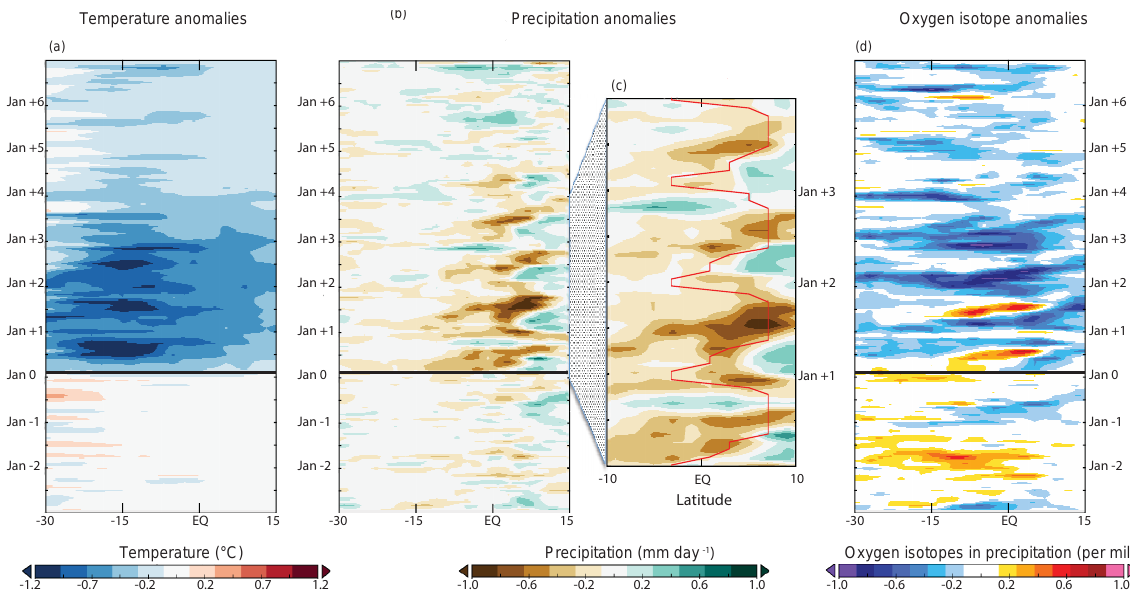
Figure 11. Last millennium Hovmöller diagram (10 years, time moving forward going upward, with year number labeled next to each month) for (a) temperature anomaly ( ◦ C) and (b) precipitation anomaly (mmday − 1 ) using procedure described in the text. Solid black lines mark closest January to start of each eruption used in composite. (c) Same as panel (b) , except zoomed in on 10 ◦ S to 10 ◦ N and over 3 years of time beginning with the January closest to each eruption. Red line in panel (c) shows latitude of maximum climatological precipitation as a function of time of year. All results zonally averaged in model from 77.5 to 45 ◦ W. (d) Last millennium Hovmöller diagram for oxygen isotopes in precipitation (per